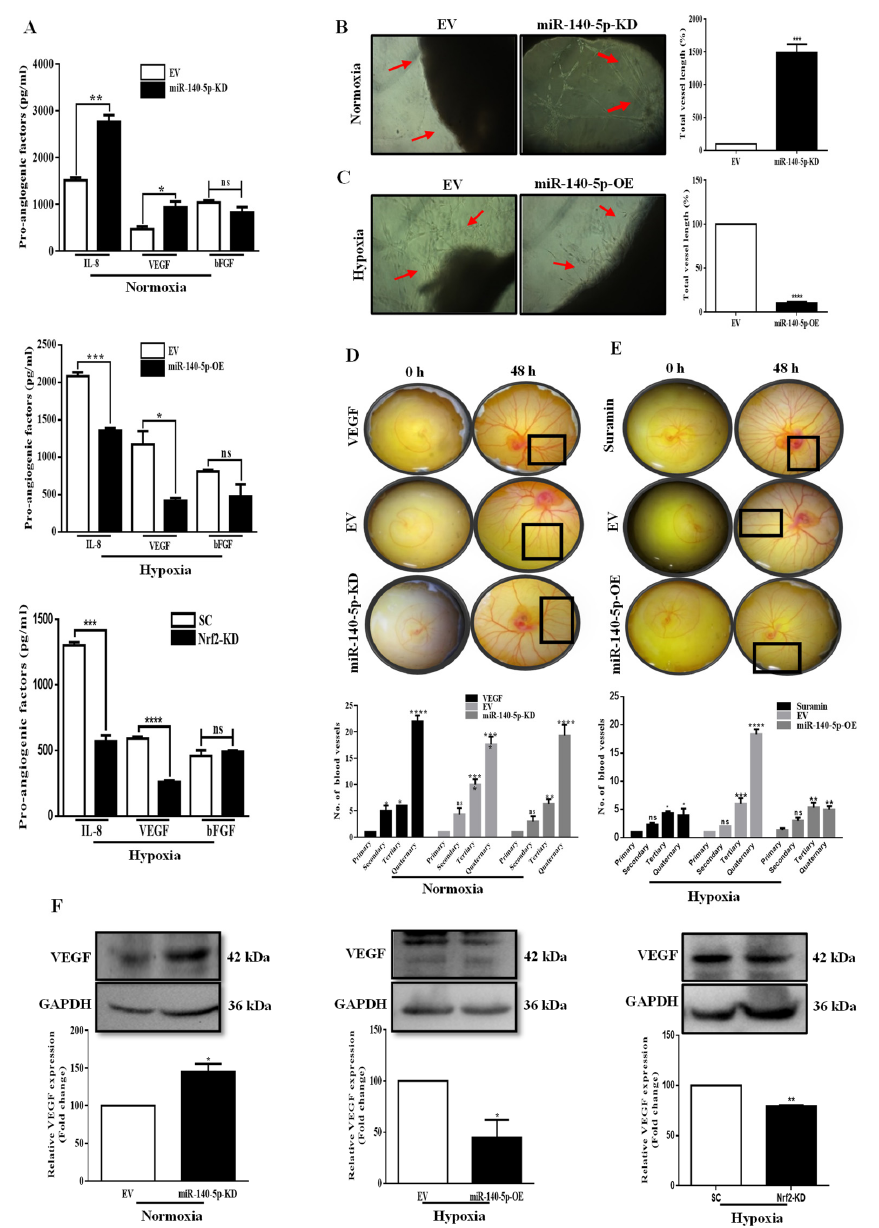
Figure 5. miR-140-5p suppresses angiogenesis in BC. ( A ) ELISA was performed to measure secretion of pro-angiogenic factors (IL-8, VEGF, and bFGF) in CM from miR-140-5p-KD cells under normoxia, miR-140-5p-OE cells or Nrf2-KD cells under hypoxia. ( B , C ) Rat aortic ring sections cultured on matrigel containing CM from miR-140-5p-KD cells under normoxia or miR-140-5p-OE cells under hypoxia. The vascularized area is indicated by red arrowheads. Quantification of the vascular area was performed using AngioTool. ( D , E ) Representative images of the chick YSM assay treated with CM from either miR-140-5p-KD cells under normoxia or miR-140-5p-OE cells under hypoxia. Here VEGF and Suramin were used as positive and negative controls respectively to test the angiogenic potential of miR-140-5p. ( F ) Analysis of VEGF expression by Western blotting in miR-140-5p-KD cells under normoxia and miR-140-5p-OE cells or Nrf2-KD cells under hypoxia. Error bars indicate mean ± SEM ( n = 3). Student’s t -tests were used to compare the means of two groups. ns: not significant, * p < 0.05, ** p < 0.01, *** p < 0.001, and **** p < 0.0001 compared to